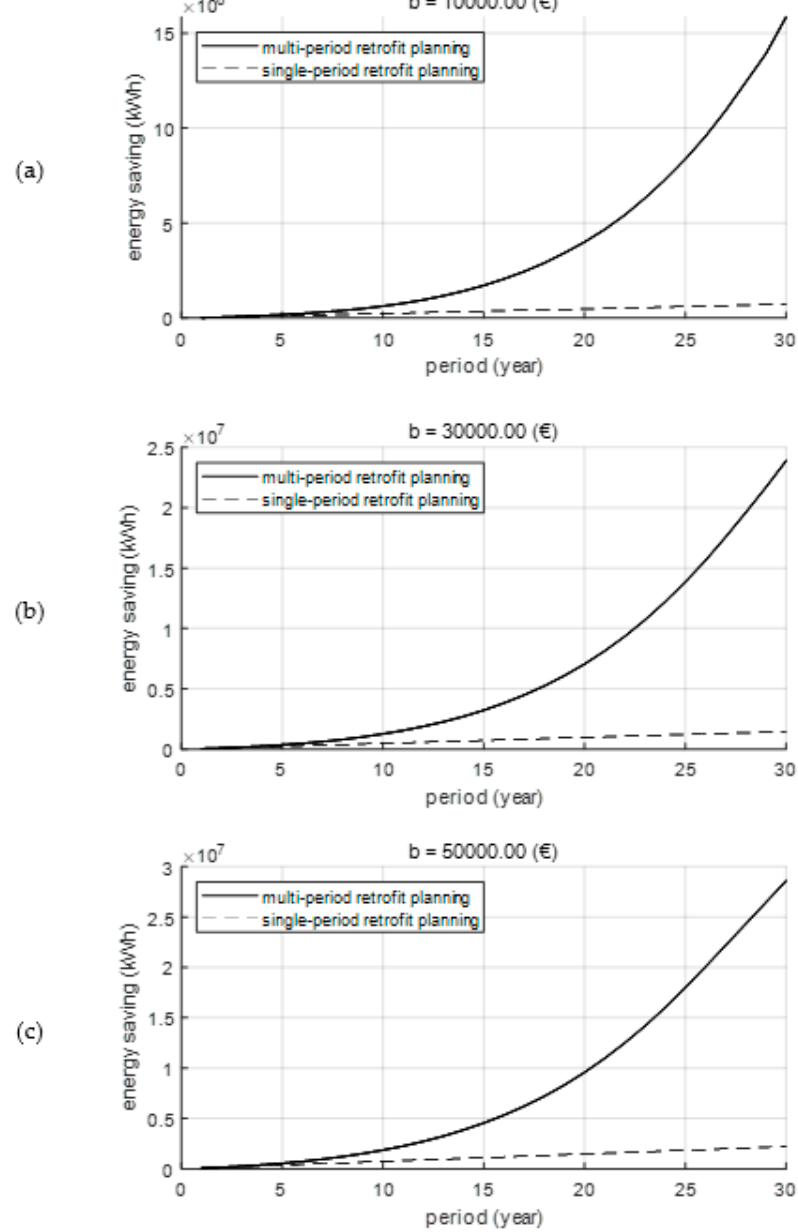
Figure 2. The cumulative energy savings over time intervals achieved by single- and multi-period retrofit planning for different initial investment budgets: ( a ) b = € 10,000.00, ( b ) b = € 30,000.00, and ( c ) b = €